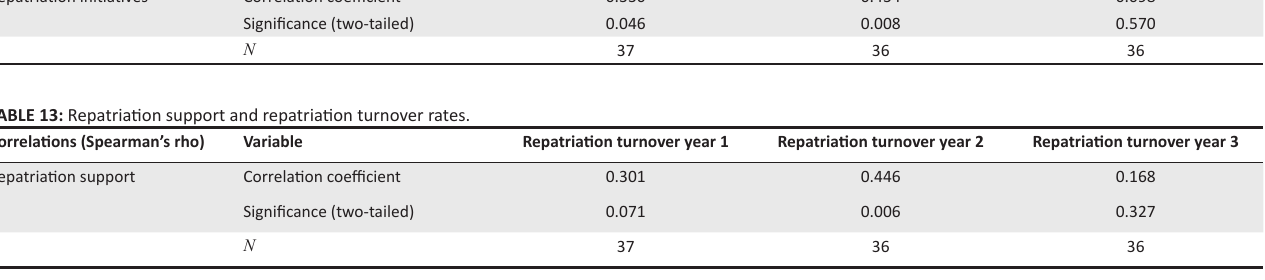
TABLE 12: Repatriation initiatives and repatriation turnover. Correlations (Spearman’s